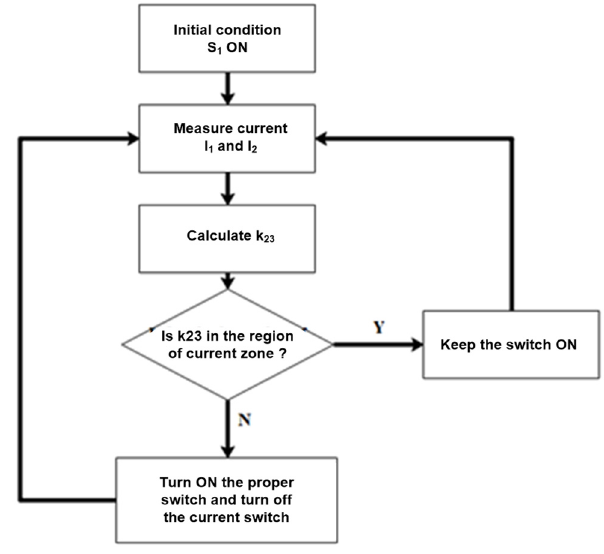
Figure 6. Flow chart of the control method.